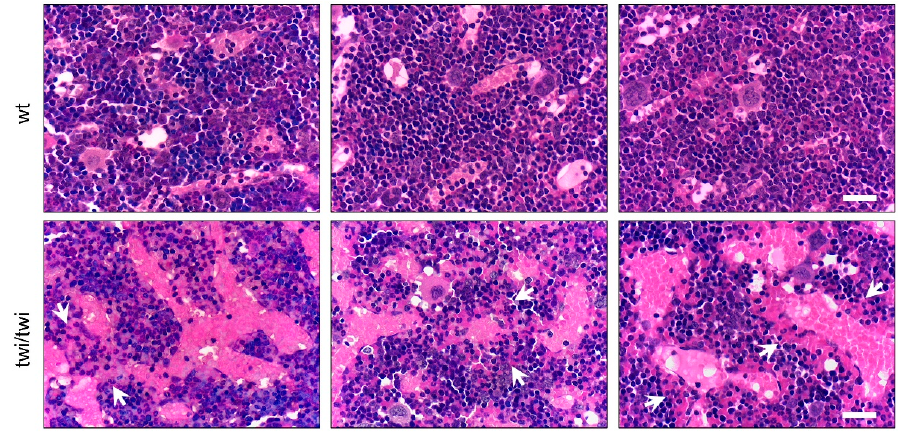
Figure 1. Abnormal BM vasculature in twitcher mice. H&E staining of femurs from three wt and three twitcher (twi/twi) mice. White arrows indicate hemorrhagic areas. Scale bar: 50 μ m. In order to get further insights into the vascular component of twitcher BM, we performed immunohistochemical staining of the endothelial markers platelet/endothelial cell adhesion molecule-1 (PECAM-1/CD31) and vascular endothelial growth factor receptor-2 (VEGFR2) that are expressed by both BM arterioles and capillaries [15]. Interestingly, immunohistochemical analysis revealed the complete absence of CD31 expression by abnormal SECs in twitcher mice, which was instead maintained in arteriolar endothelium (Figure 2A).